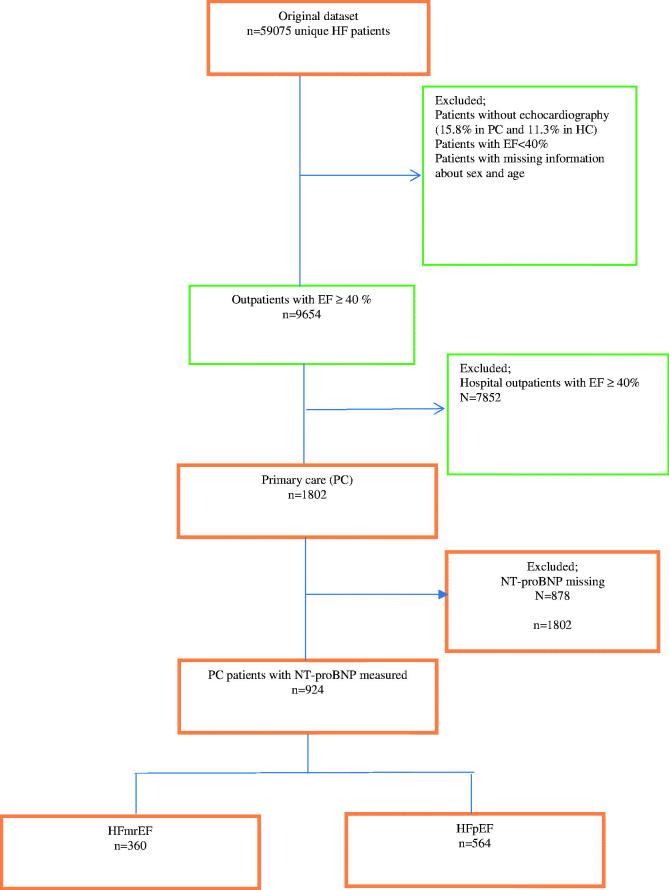
Schematic patient selection.